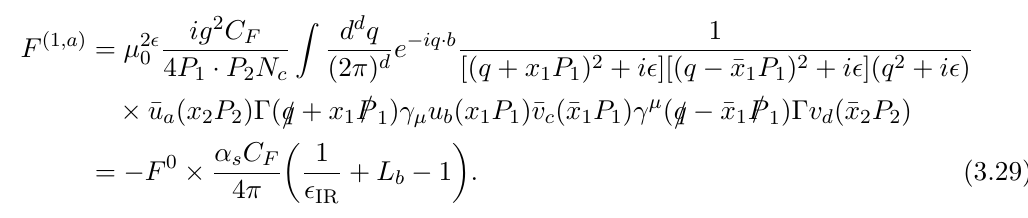
JHEP09(2022)046